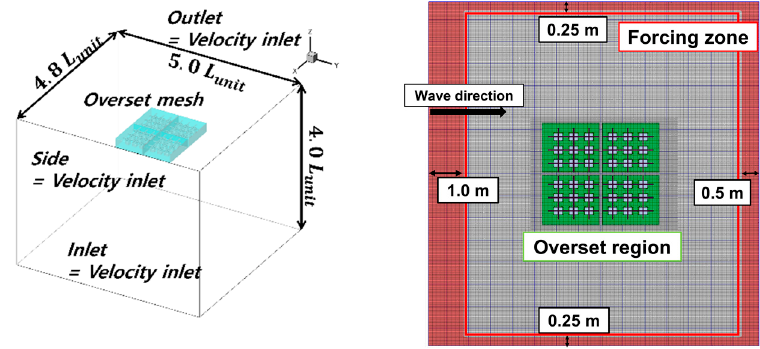
Figure 7. Computation domain and boundary conditions for head sea conditions.